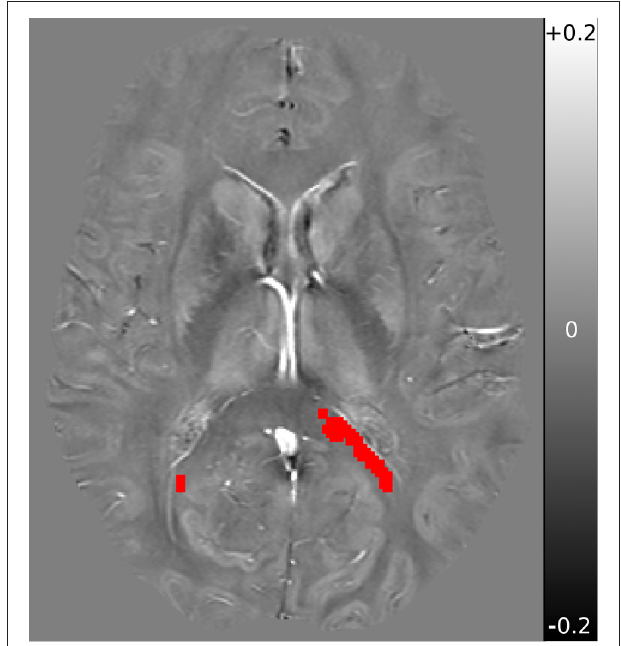
FIGURE 1 | Sample QSM axial slice of a subject obtained at baseline, with overlay registered VOI mask in red. QSM underlay is shown in the range of − 0.2 ppm (black) to + 0.2 ppm (white), with 0 ppm shown in neutral